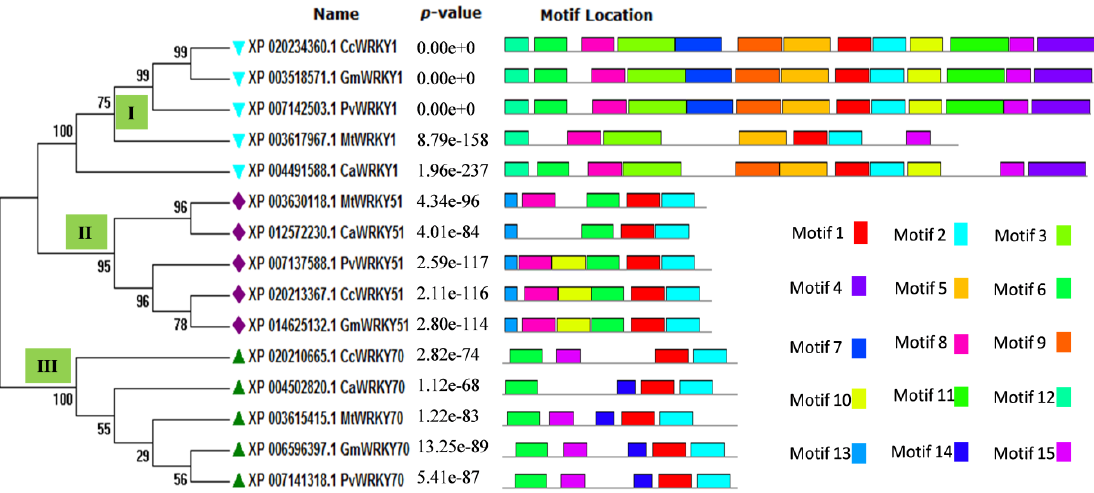
Figure 3. Predicted 3D structure of ( a ) Type I WRKY DBD; ( b ) Type II; and ( c ) Type III WRKY DBDs from pigeonpea. The ligand-binding pockets shown in blue color.